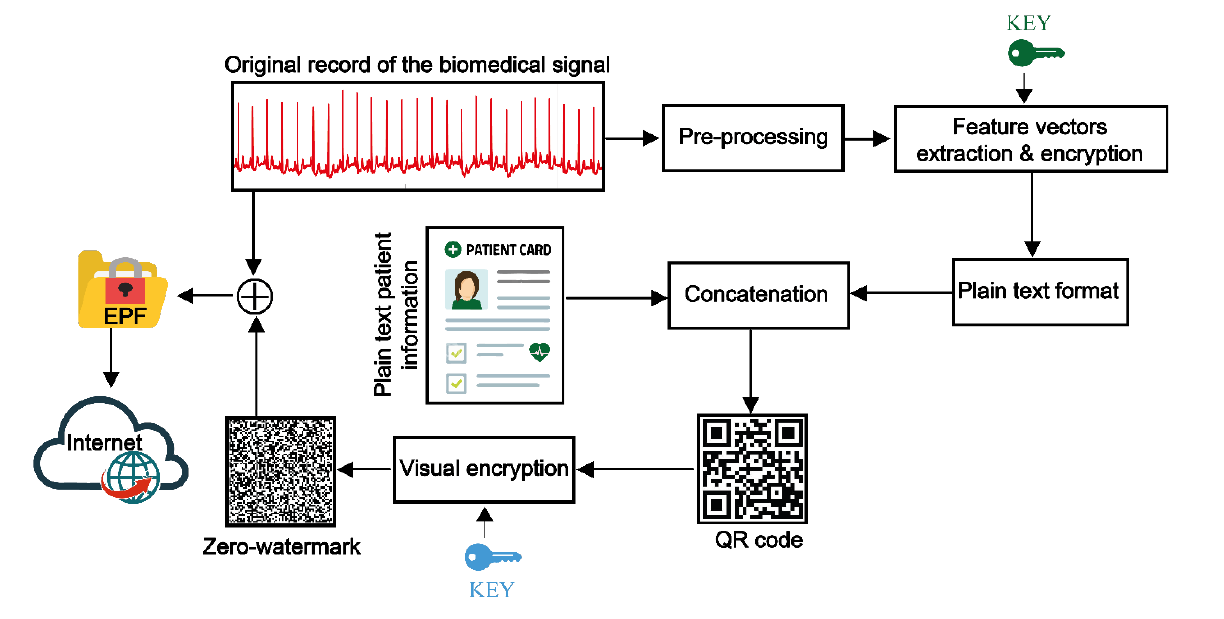
Figure 4. The proposed security algorithm.